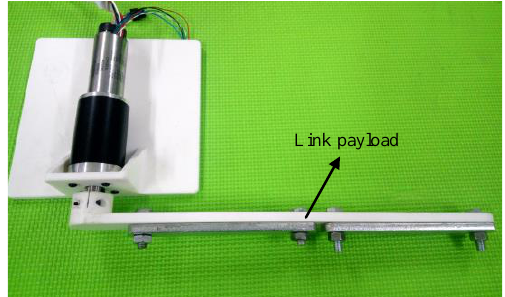
Figure 13. The motor with link payload after the gearbox.